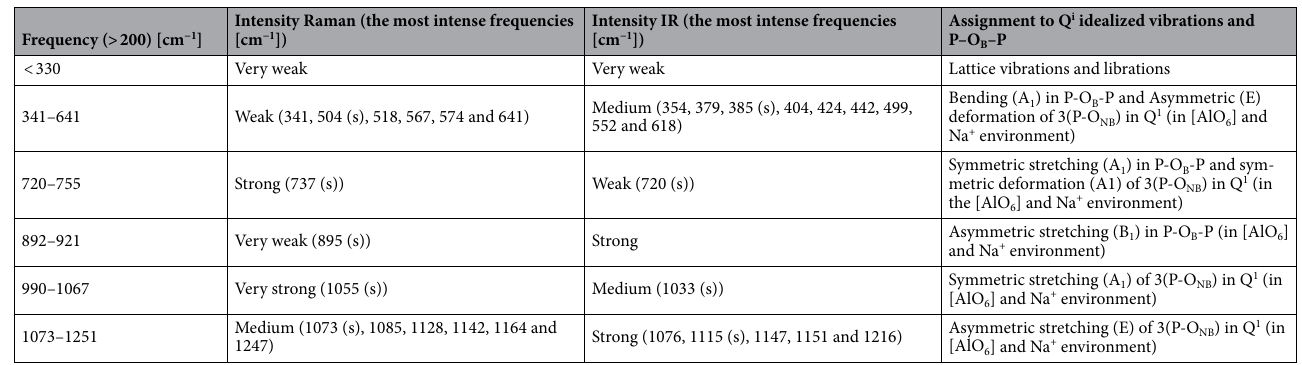
Table 5. The calculated Raman and IR active modes of NaAlP 2 O 7 (more details in the supplementary material Table S1.5). s—the strongest in